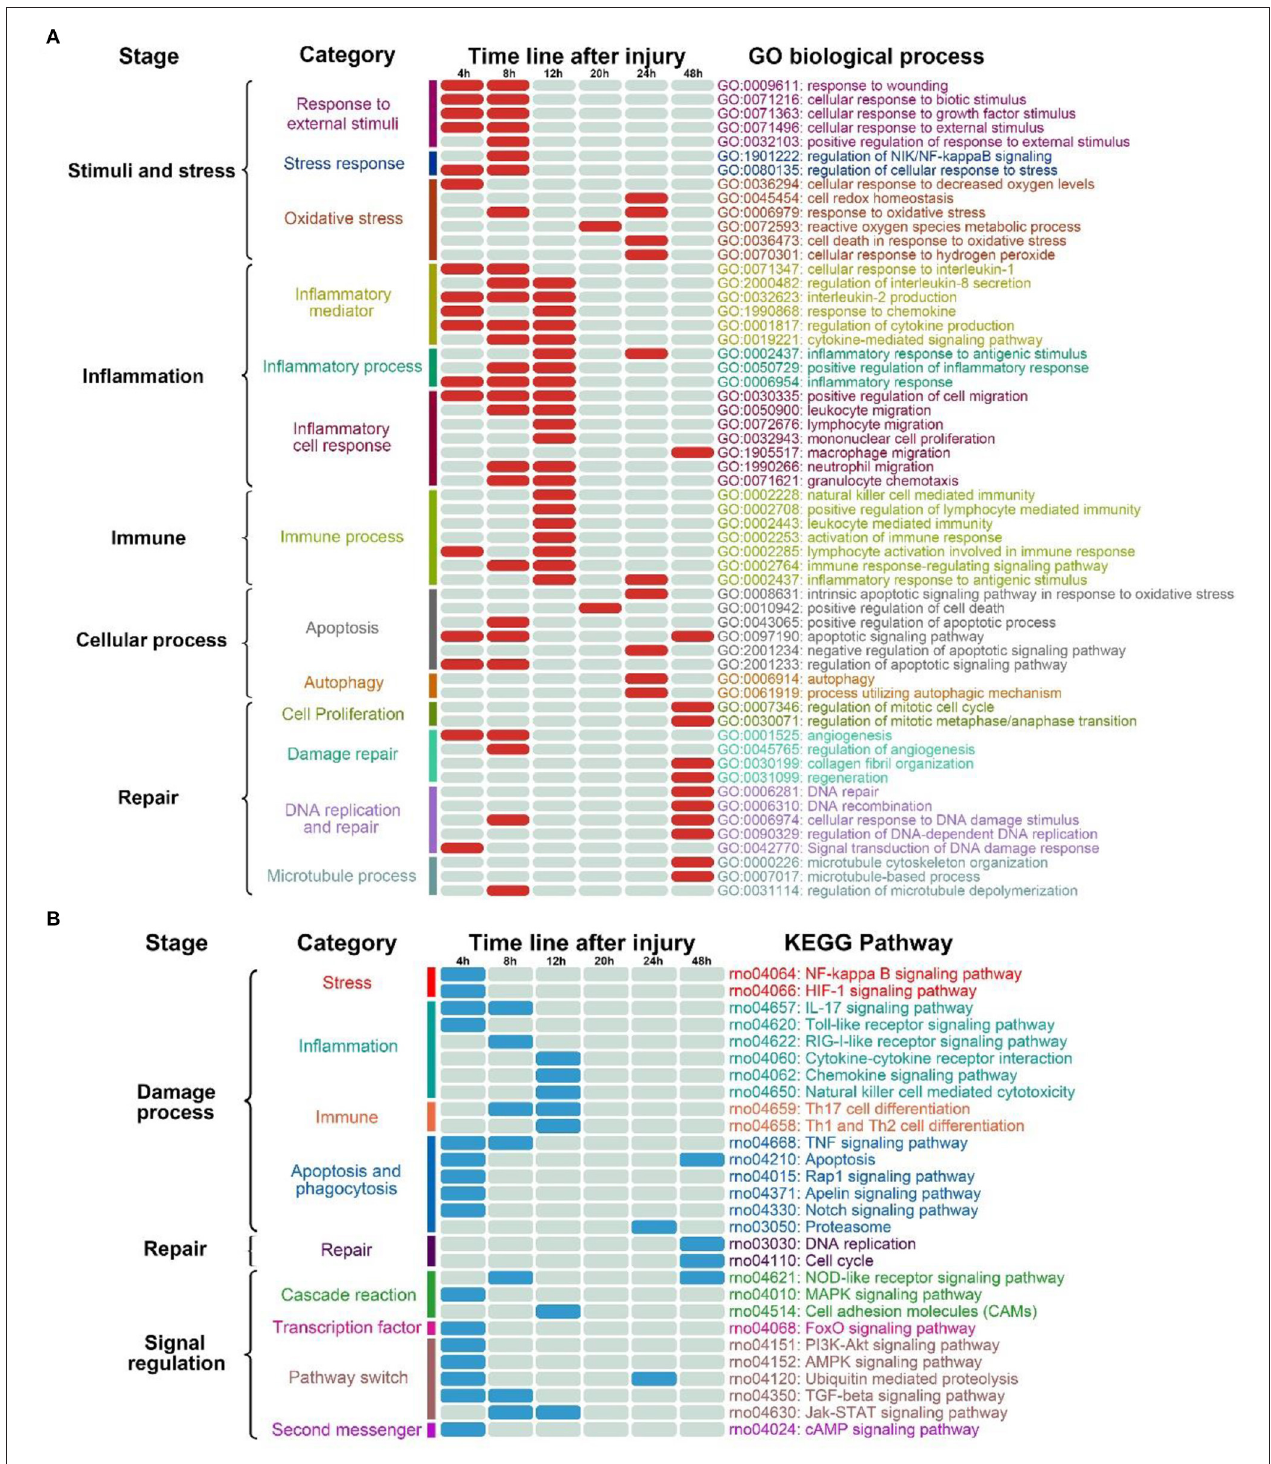
FIGURE 2 | Variation in transcriptional dynamics during the early period after SMI. (A) Changes in transcription during post-SMI repair associated with biological processes based on GO analysis. Different colors represent different sub-classes associated with detailed bioprocesses. Further information regarding the GO terms enriched in each sub-class is listed on the right in the same colors. Solid red cells in the table represent the GO terms enriched in the module representing each time-point during the course of injury repair. (B) Changes in transcription during post-SMI repair associated with KEGG pathways. Different colors represent different sub-classes associated with detailed pathways. Further information regarding the KEGG pathways enriched in each sub-class is listed on the right in the same colors. Solid blue cells in the table represent the KEGG pathways enriched in the module representing each time-point during the course of injury repair.